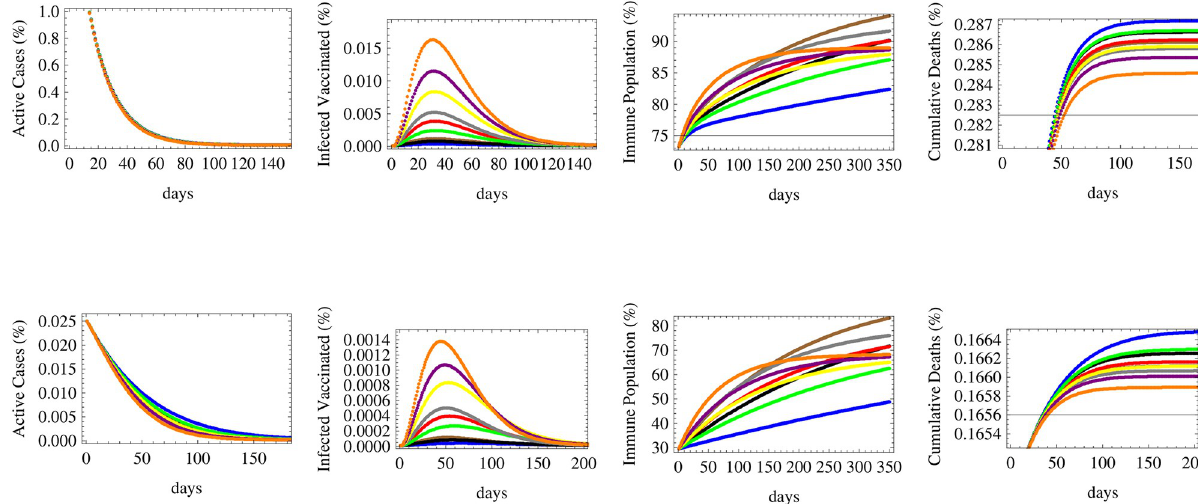
Fig 3. The figure shows the relative numbers of active cases, infected vaccinated cases, immune population and total cumulative deaths for a medium reproductive rate R = 1.1 with the same two initial conditions and nine vaccination scenarios of Fig 2.